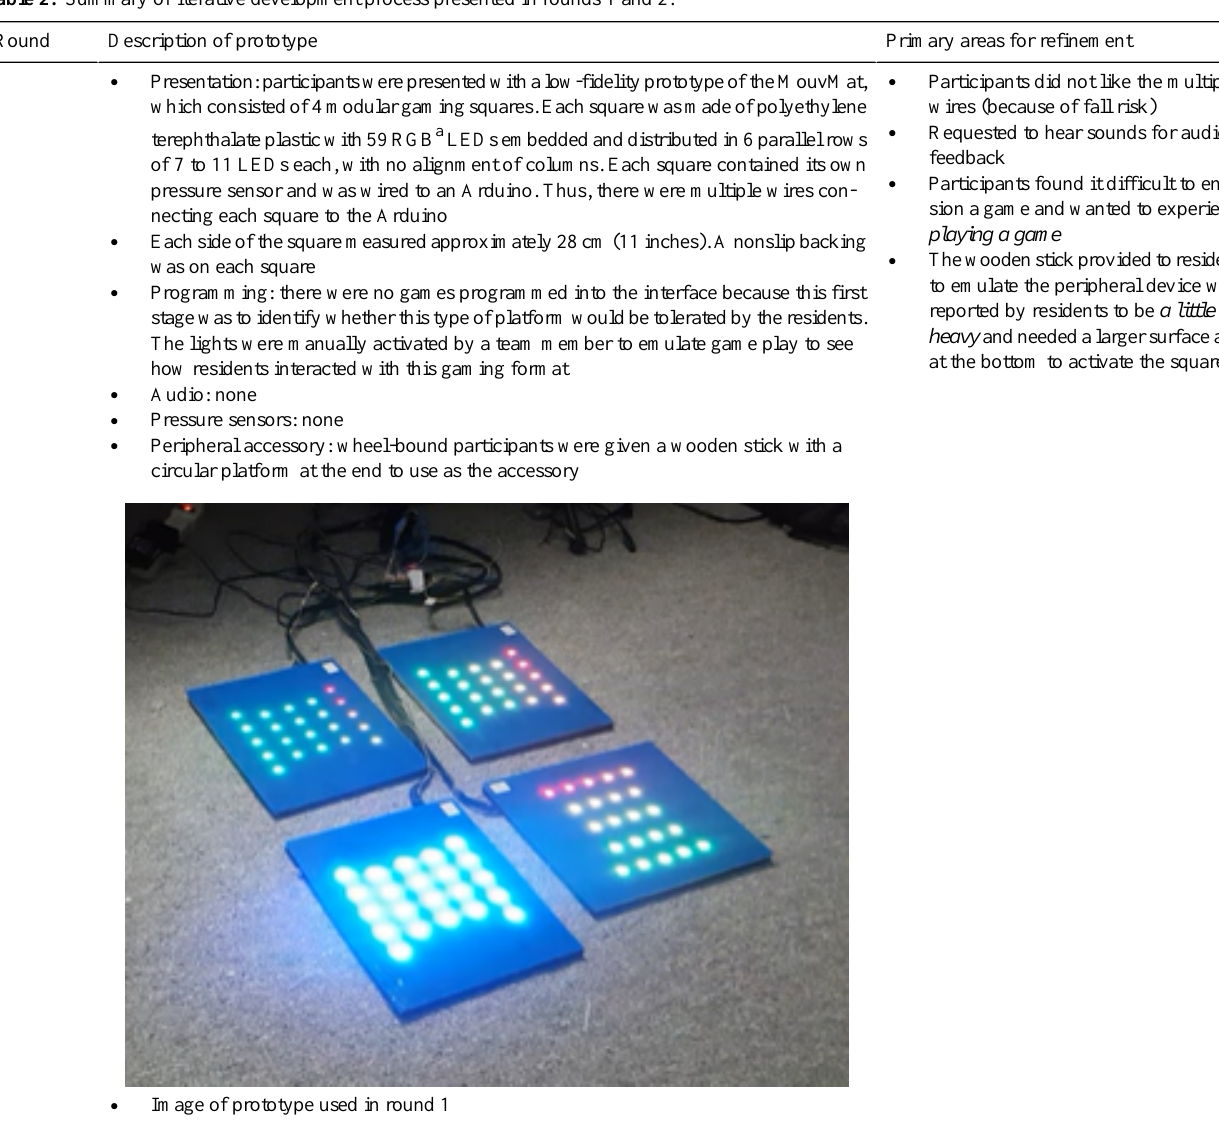
Table 2. Summary of iterative development process presented in rounds 1 and 2.